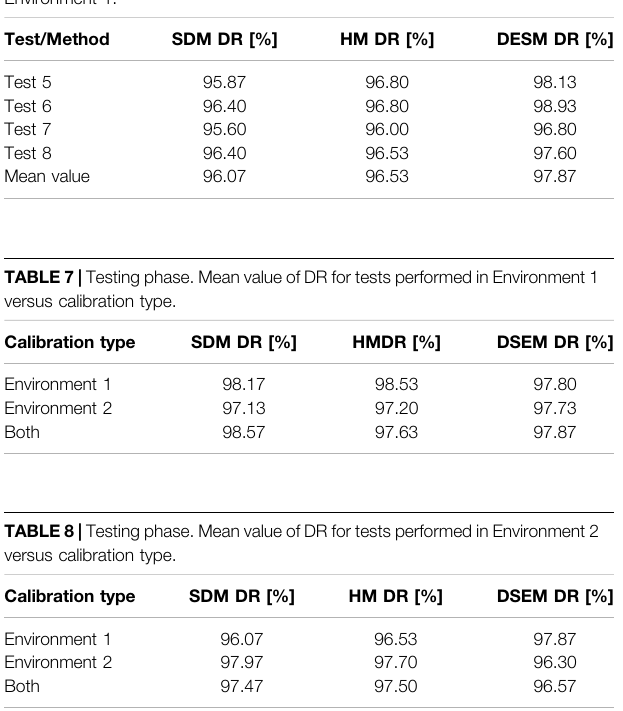
TABLE6| Testingphase.DRandmeanvaluesforSDM,HM,DESMachievedwith Test 5, 6, 7, 8 performed in Environment 2 with detection thresholds of Environment 1.